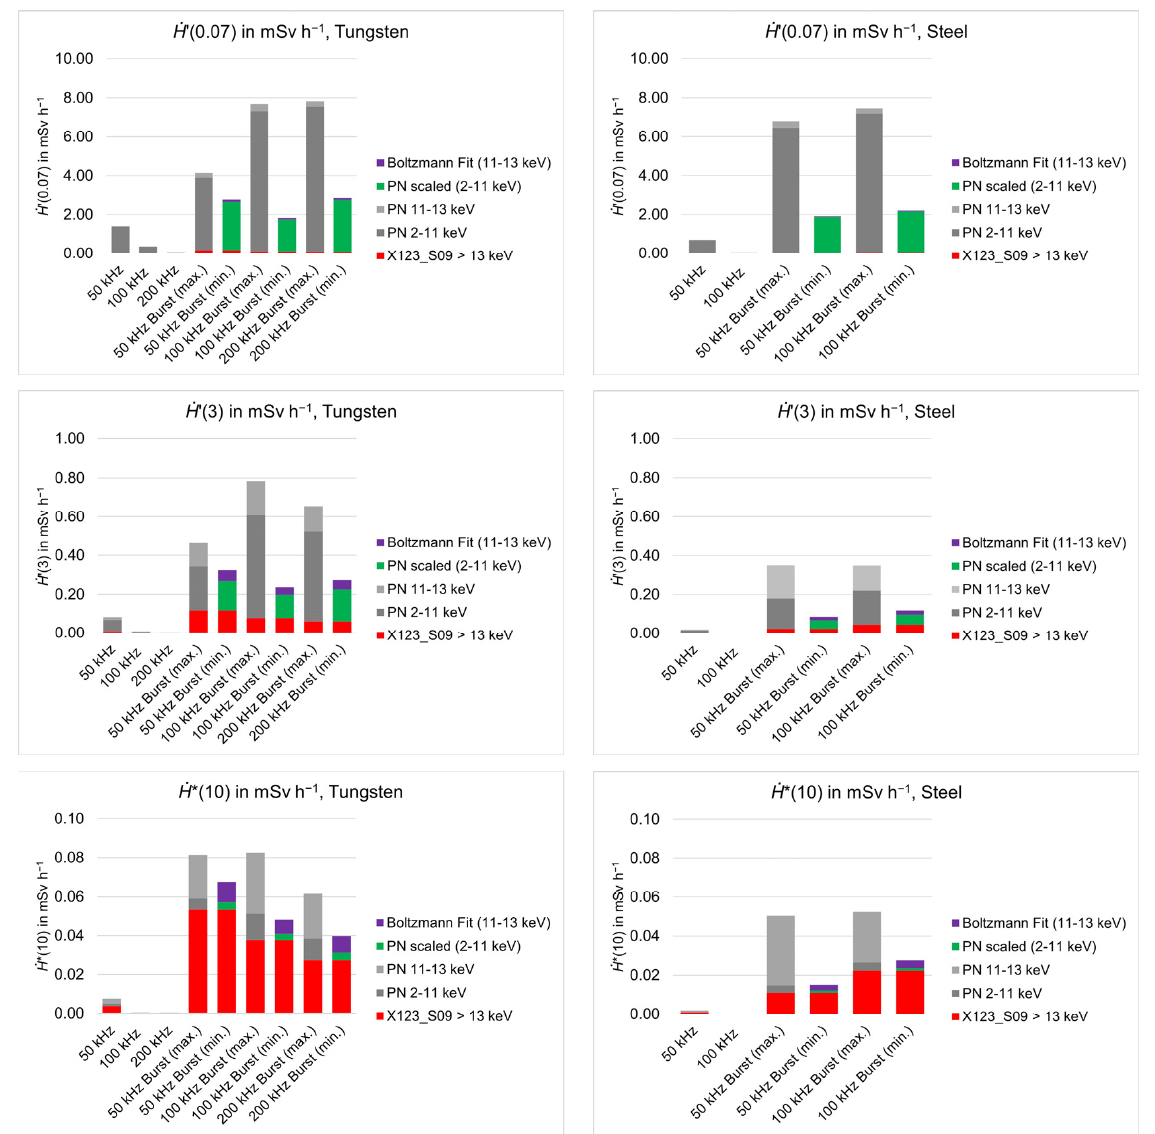
Figure 10. Dose equivalent rate estimations for the quantities Ḣ ′ (0.07), Ḣ ′ (3), and Ḣ *(10), as calculated from the spectra presented in Figures 8 and 9. The results for laser processing of tungsten are summarized in the left column, while the results for laser processing of steel are given in the right column.